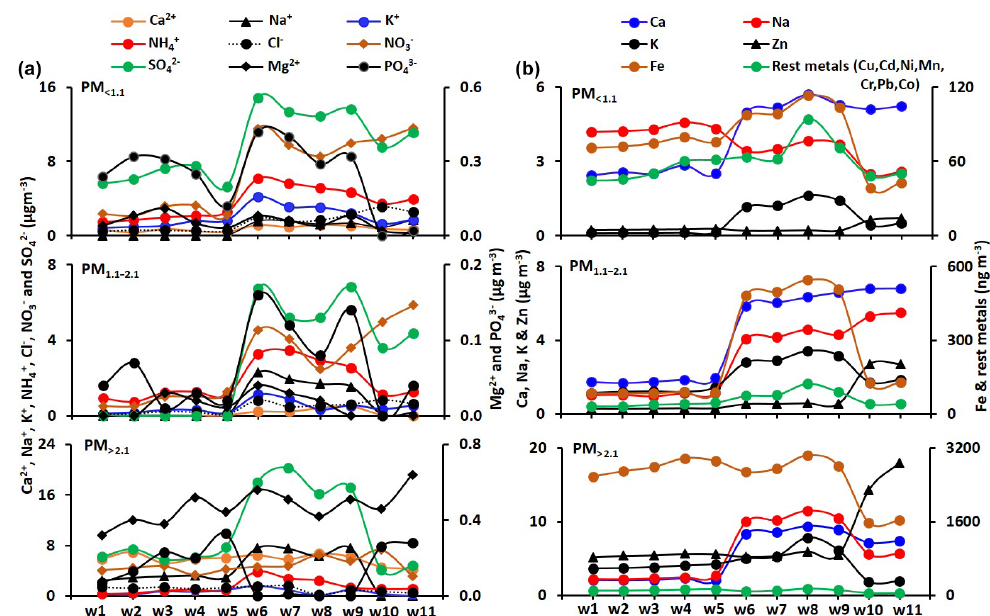
Figure 3. Variation in (a) ions and (b) trace metals in different aerosol size